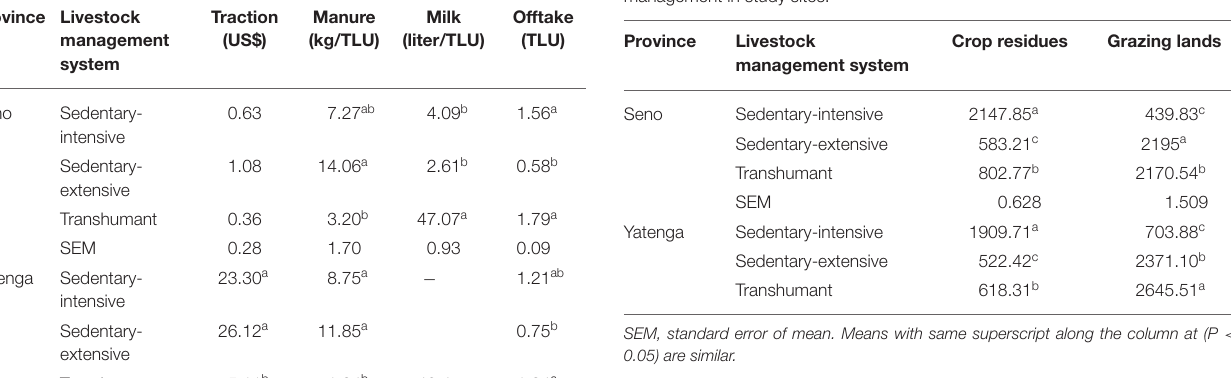
TABLE 4 | Water depleted (m 3 /ha) by the feed types in different livestock management in study sites.